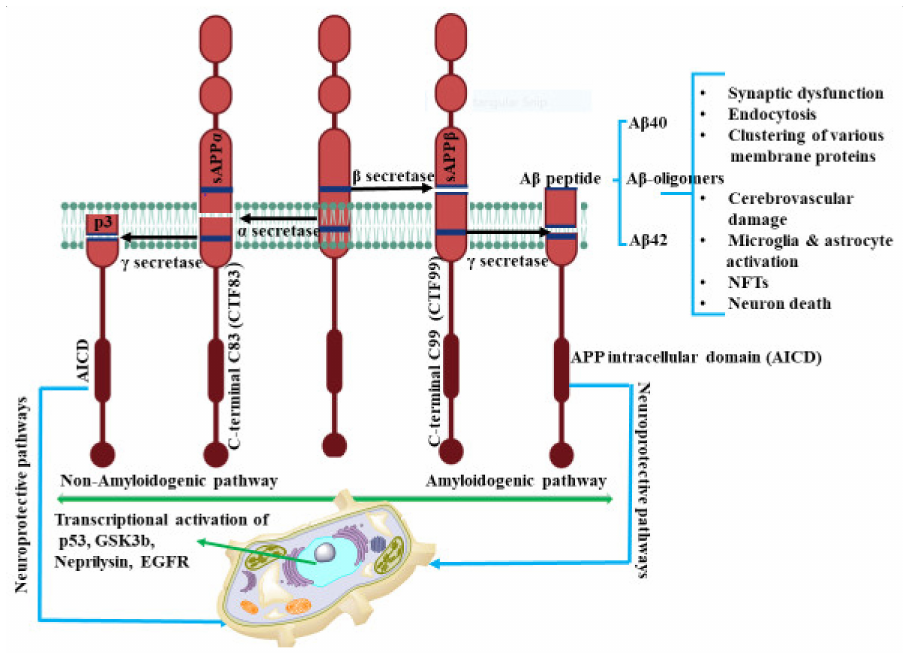
Figure 1. The amyloidogenic and non-amyloidogenic pathways. In non-amyloidogenic pathways, the APP cleavage occurs by α -secretase and produces CTF83 and sAPP α . sAPP α promotes neurite outgrowth, synaptogenesis, and cell adhesion. Further γ cleavage of CTF83 leads to the formation of AICD and p3. However, in the amyloidogenic pathway, β -secretase cleaves APP and results in formation of CTF99 and sAPP β . γ cleavage of CTF99 leads to the formation of AICD and A β peptide. AICD generated by γ -secretase cleavage of CTF83 or CTF99 plays a role in nuclear translocation and transcriptional activation of target genes such as p53, GSK3 β , neprilysin, EGFR. The biological relevance of CTF83 and CTF99 generated by α - and β -secretase, respectively, is unknown. A β peptide results in synaptic impairment and destroys the integrity of brain functions through various progressions. The figure was created using tools obtained from